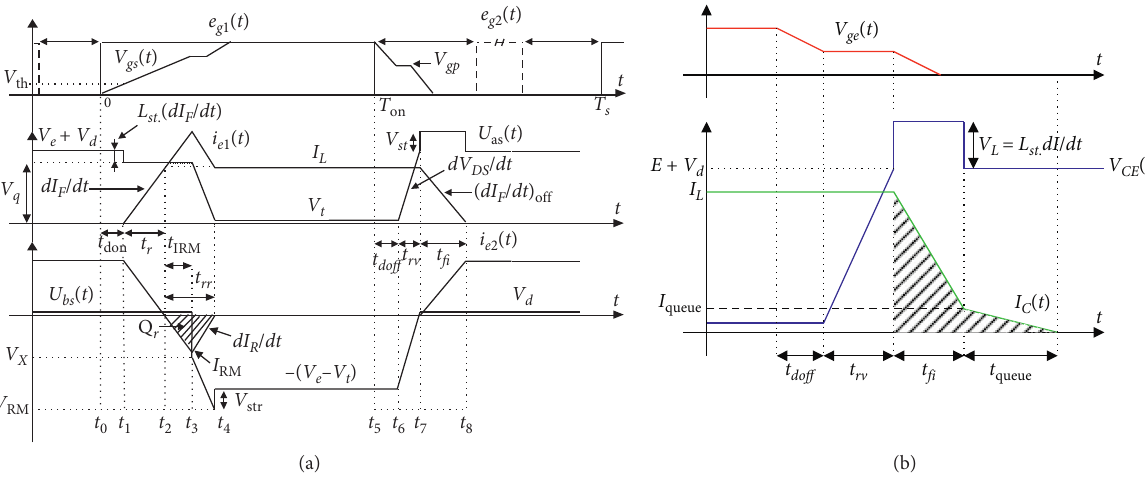
Figure 3: Adopted switching characteristics in the PWM-switch of (a) MOSFET and diode over a switching period. (b) IGBT during blocking commutation.